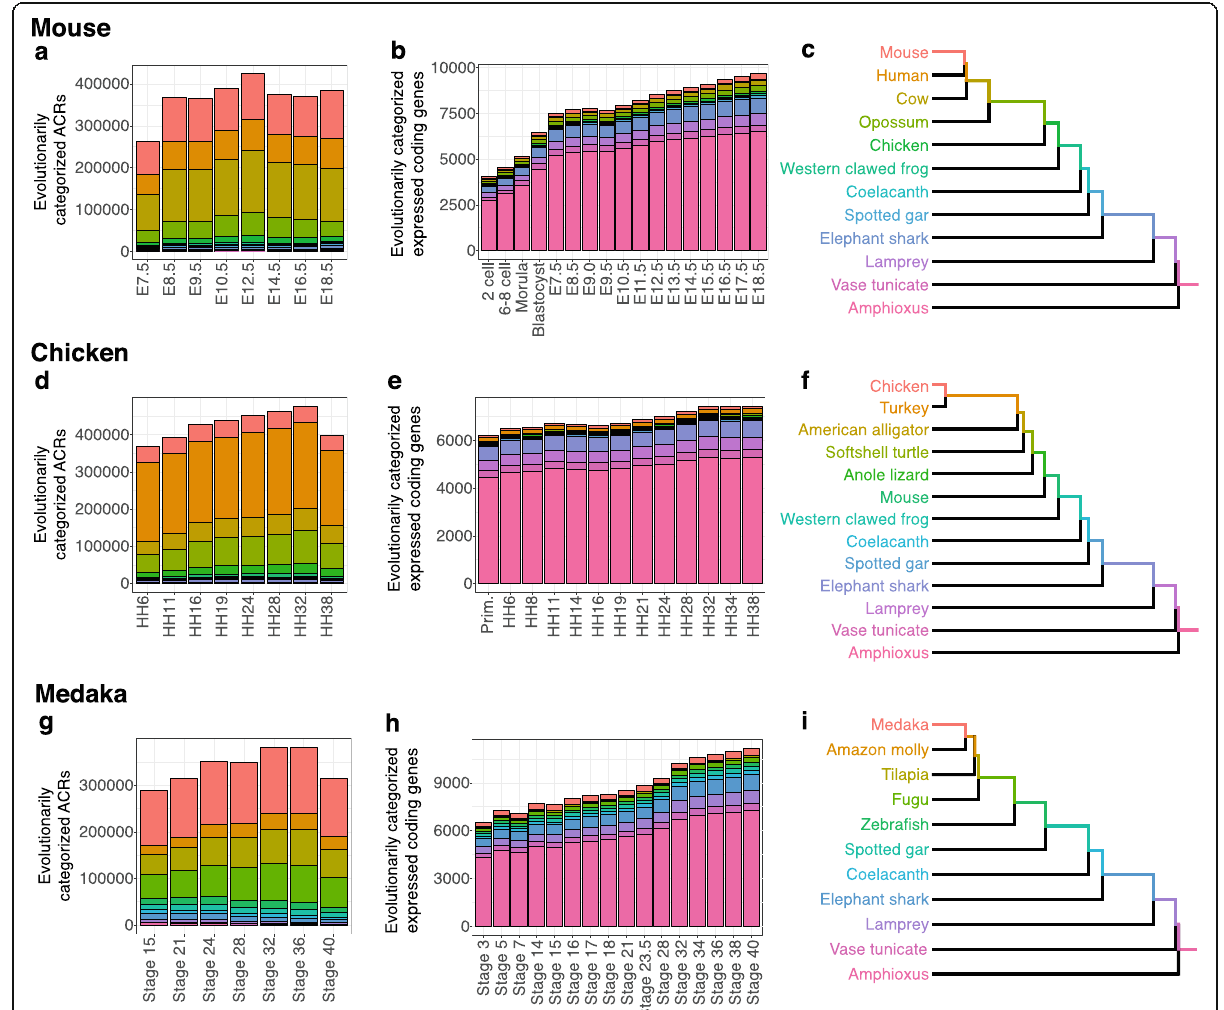
Fig. 2 Numbers of ACRs and expressed protein-coding genes categorized according to evolutionary ages. Stacked bar graphs show the numbers of evolutionarily categorized ACRs ( a , d , g ) and expressed (FPKM > 1) protein-coding genes ( b , e , h ) at each developmental stage in mouse ( a , b ), chicken ( d , e ), and medaka ( g , h ). Evolutionary ages of ACRs were estimated based on Method I (for details, see Methods and Additional file 2: Figure S4). The evolutionary ages of protein-coding genes were estimated according to the most recent common ancestors of all the species sharing the homologs; the expressed genes that were estimated to be lost secondarily in any of the compared species were excluded (see Methods for details). Colors in each stacked bar graph indicate the categories of the evolutionary ages of each element. Each evolutionary category includes ACRs or expressed protein-coding genes that originated during the correspondingly colored period in the phylogenetic trees shown in c , f , and